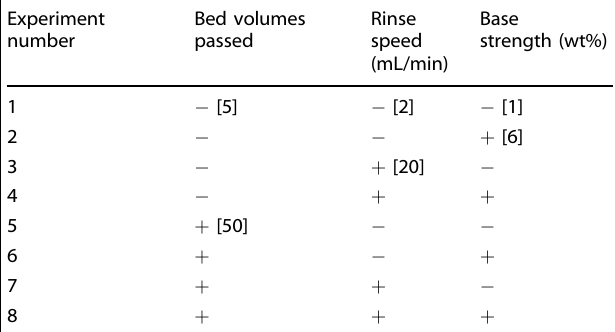
Table 2. 2 3 full-factorial experimental design (experimental sets A – C).